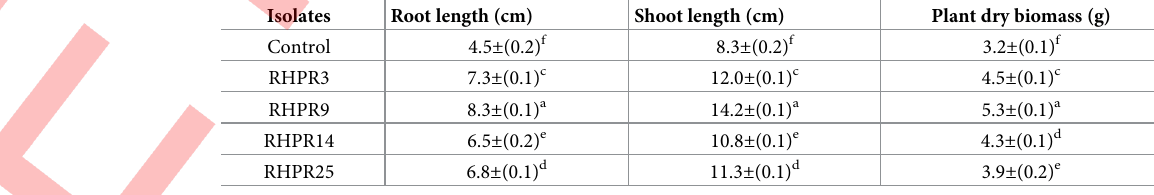
Table 3. Evaluation of plant growth of in chilli on treatment with Streptomyces spp. under greenhouse conditions.